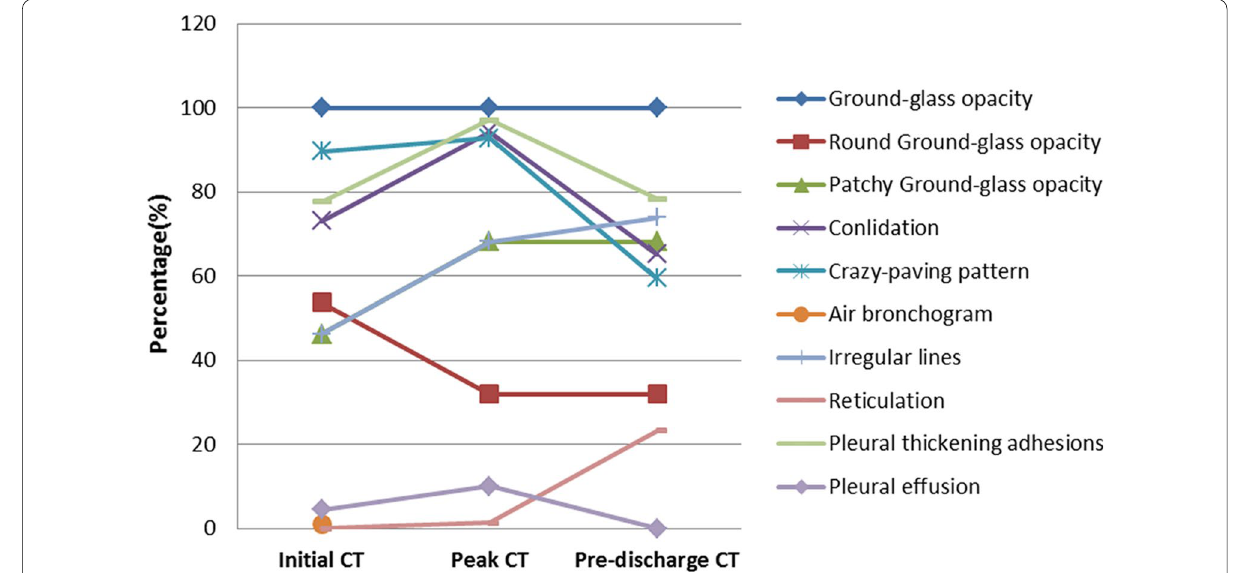
Fig. 7 The CT appearences on the initial CT, peak CT, and pre‑discharge CT